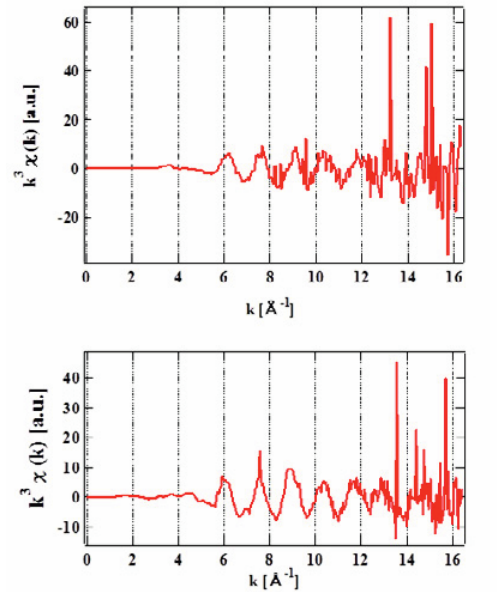
Figure 3. XAFS χ function weighted with photoelectron wave number k 3 for ZnSnAs 2 thin films doped with 5.0% and 6.5 % Mn.